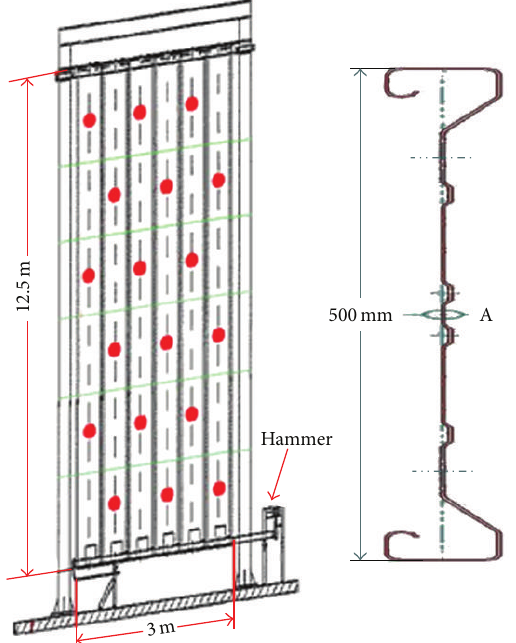
Figure 16: Schematic image for the frame consists of six collecting plate used for acceleration measurements (red points show the locations of the accelerometers).